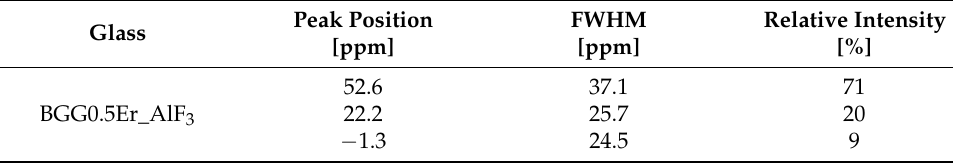
Table 4. Deconvolution of 27 Al MAS-NMR